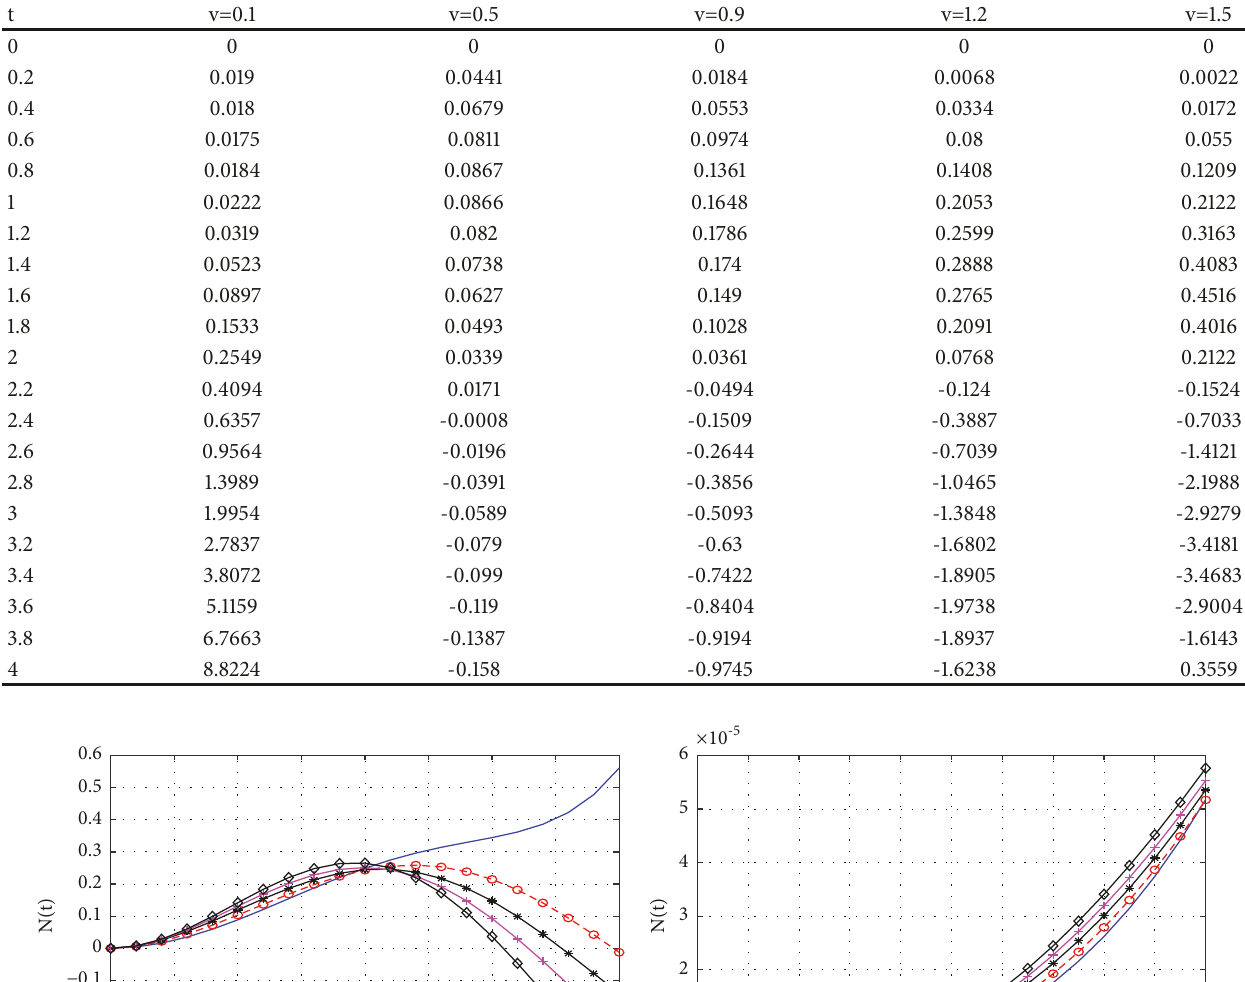
Table 1: The numerical results of Theorem 1 for the parameters listed in Figure 1(a).